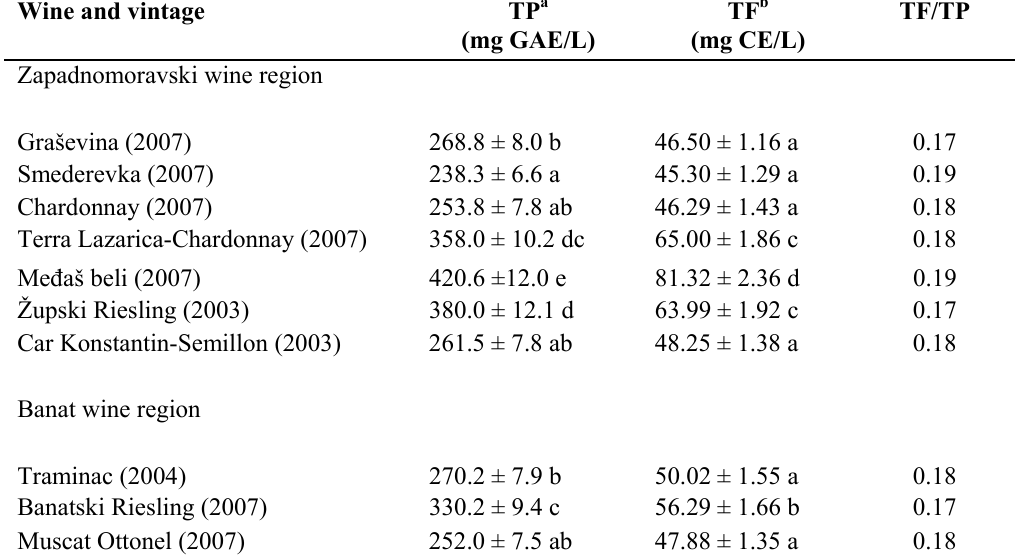
Table 1. Total phenol (TP) and total flavonoid (TF)